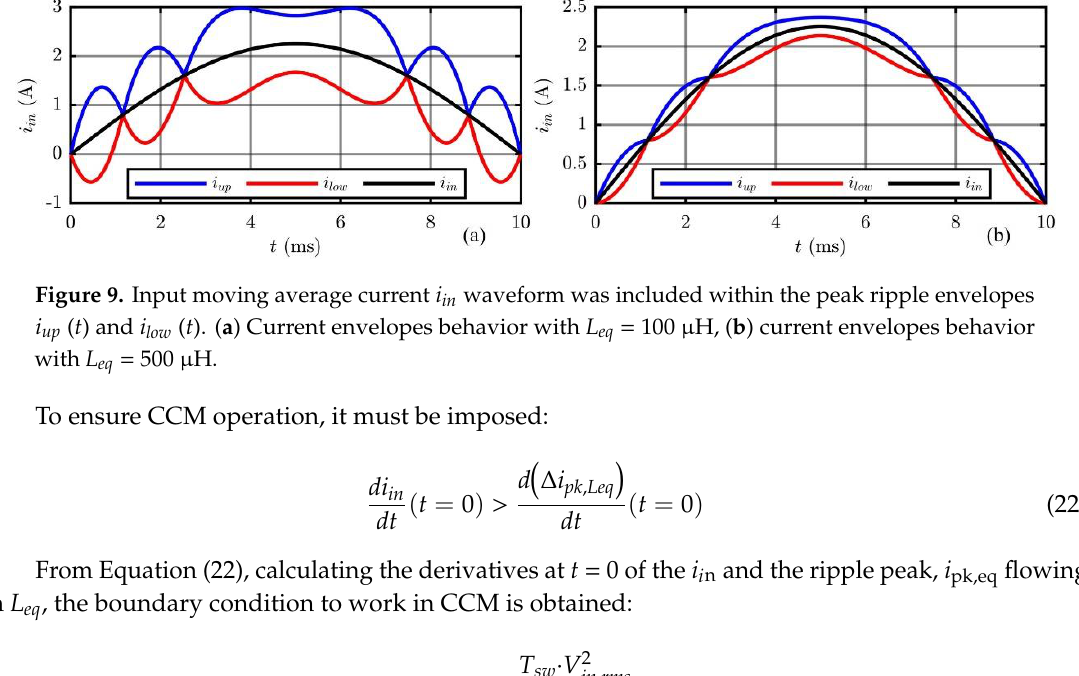
Figure 8. ( a ) Peak current ripple and input current comparison for L eq = 900 μH, ( b ) Peak current ripple and input current comparison for L eq = 300 μH.